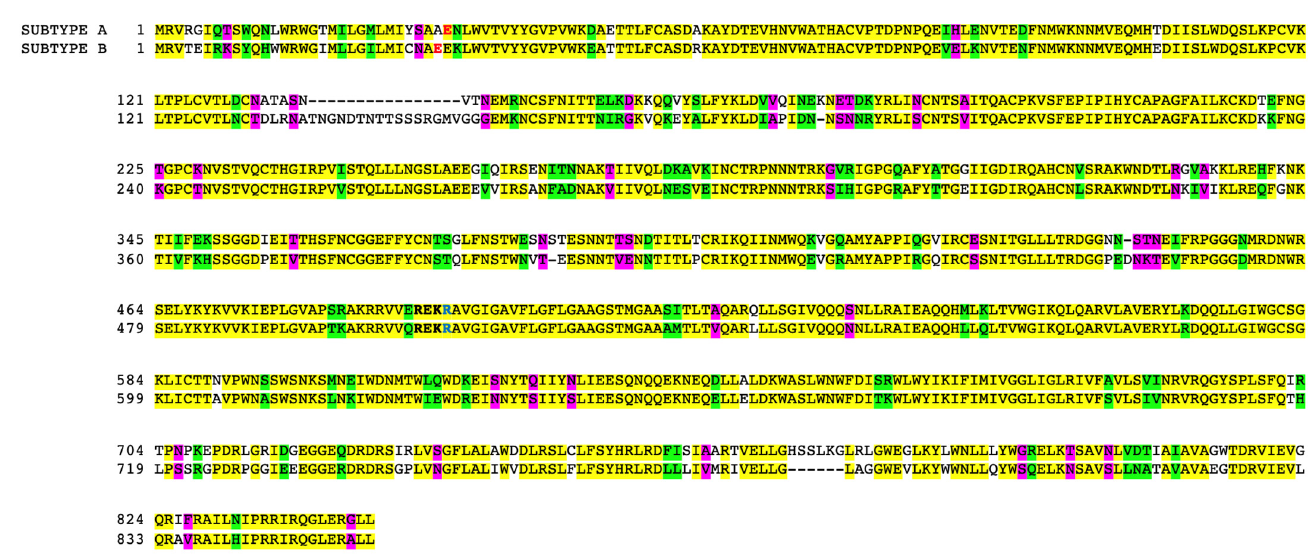
Figure 1. Amino acid sequence alignment of gp160 Subtype A and Subtype B. Amino acid sequence alignment of gp160 proteins of HIV-1 Group M Subtype A (Accession# AAT67478.1) and Subtype B (AAA44191.1). The furin cleavage sequence (REKR) is shown in bold. Amino acids that are identical between Subtype A and Subtype B are highlighted in yellow, and strongly and weakly similar amino acids are highlighted in green and purple, respectively, in accordance with the definition by Clustal Omega. The first and last amino acids of the recombinant pg120 proteins of Subtypes A and B that were used experimentally in this study are shown in bold red and blue letters, respectively. Table 1. Characteristics of recombinant proteins used in this